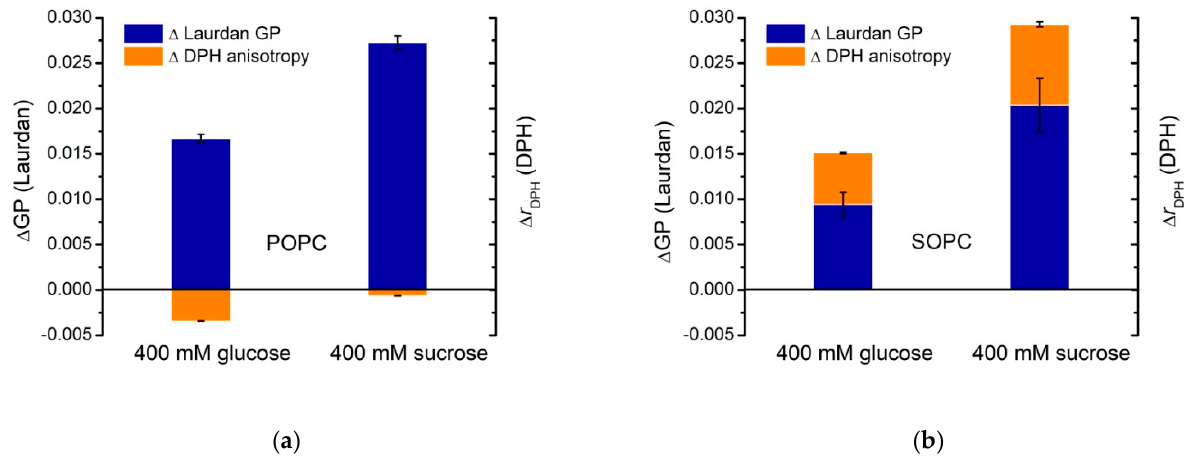
Figure 9. ∆ GP and ∆ r DPH calculated as the difference between DPH anisotropy or Laurdan GP of ( a ) POPC and ( b ) SOPC vesicles in 400 mmol/L glucose or sucrose and in water (control) at 20 °C. DPH anisotropy and Laurdan GP values represent the mean of three independent experiments. The error bars correspond to the standard deviations.